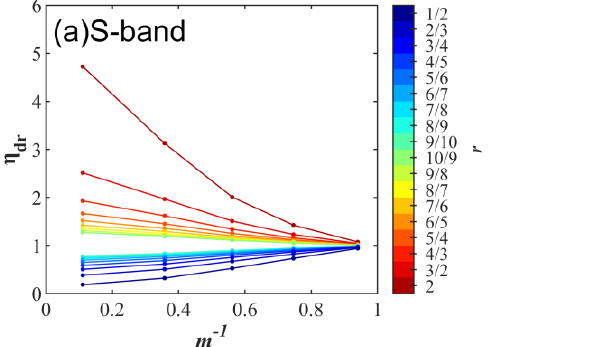
Figure 4. Linear approximation between m r , η dr and r of a single ellipsoidal particle. ( R 2 is the goodness of fit, and P is the significance of the linear fit.. ( a ) S-band, ( b ) X-band. Three points also need to be noted: (1) The approximate linear relationship in Figure 4 is not the most accurate approxi- mation. If r is logarithmic, an approximation with less error can be constructed. However, the approximate linear relationship shown in Figure 4 and Equation (9) is now more read- ily available for deriving the new index presented below. Therefore, Equation (9) is still used. (2) The process of eliminating E will be shown in Section 2.3; thus, the values of E , a 1 , and a 0 in Equation (8) are no longer discussed in the following sections. (3) The effects of radar scanning elevation, particle orientation and nonellipsoidal shape are not considered here. Therefore, r should be considered as the flattening or nar- rowing of the particle in the horizontal and vertical polarization directions as detected by the radar. 2.2. Approximate Relationship Between ρ hv and Reflectivity In this section, an approximate relationship between ρ hv and the reflectivity variables is proposed for the derivation of the new parameter presented in Section 2.3. According to the principles involved in dual polarization radar detection, ρ hv itself reflects the uni- formity of the particle shape in the detection volume, but it is also affected by the radar observation system and noise [37,38]. Referring to the basic definition of ρ hv , the ideal ρ hv formula [3] is shown in Equation (10):